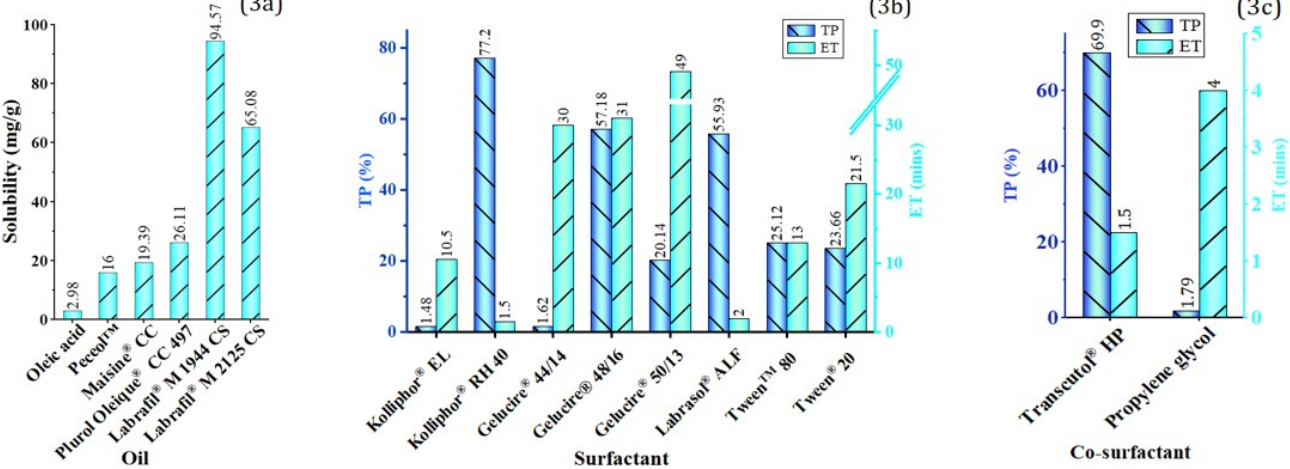
Figure 3. ( a ) RPC solubility in different oils, ( b ) ET and TP for Labrafil ® M 1944 CS with the different surfactant mixture, ( c ) ET and TP for Labrafil ® M 1944 CS and Kolliphor ® RH 40 with the different co-surfactant mixture.